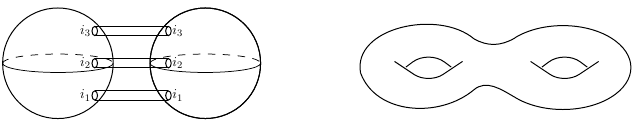
Figure 1 . Sewing two three-punctured spheres yields a genus two